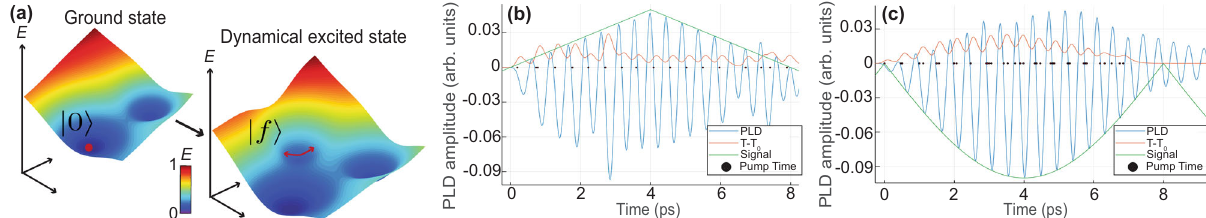
Fig. 4 Simulation of a pulse train excitation. a Phenomenology for advanced control, suspending the system starting in a ground state |0> in an excited state |f>. Energy ( E ) surface shown. b , c Optimal control of the oscillation, guiding the envelope of the PLD signal (blue lines) along the desired (green lines) b triangular or c sinusoidal curve by applying a train of 15 pulses with the same fl uence, timed at the moments indicated by black circles on the horizontal axis. The deviation from the initial temperature is plotted in orange. The simulations used the model parameters determined from the